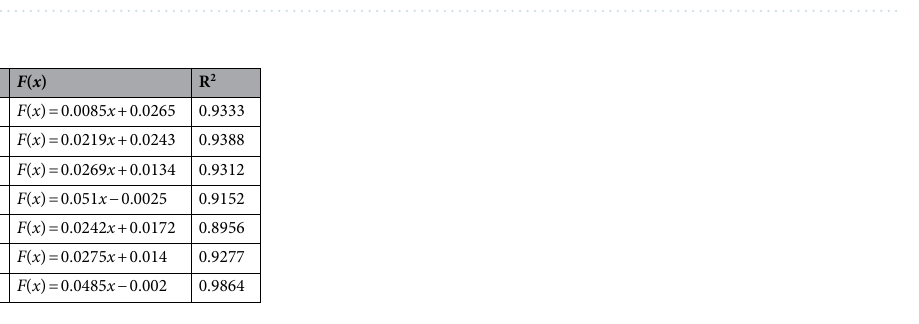
Figure 9. Relationship between shear force of runoff τ and soil separation rate D r of seven types of litter layer. Dr is the rate of soil separation; N1–N7 are treatments, see Table 2 for treatment specifics; τ is the shear force of runoff.